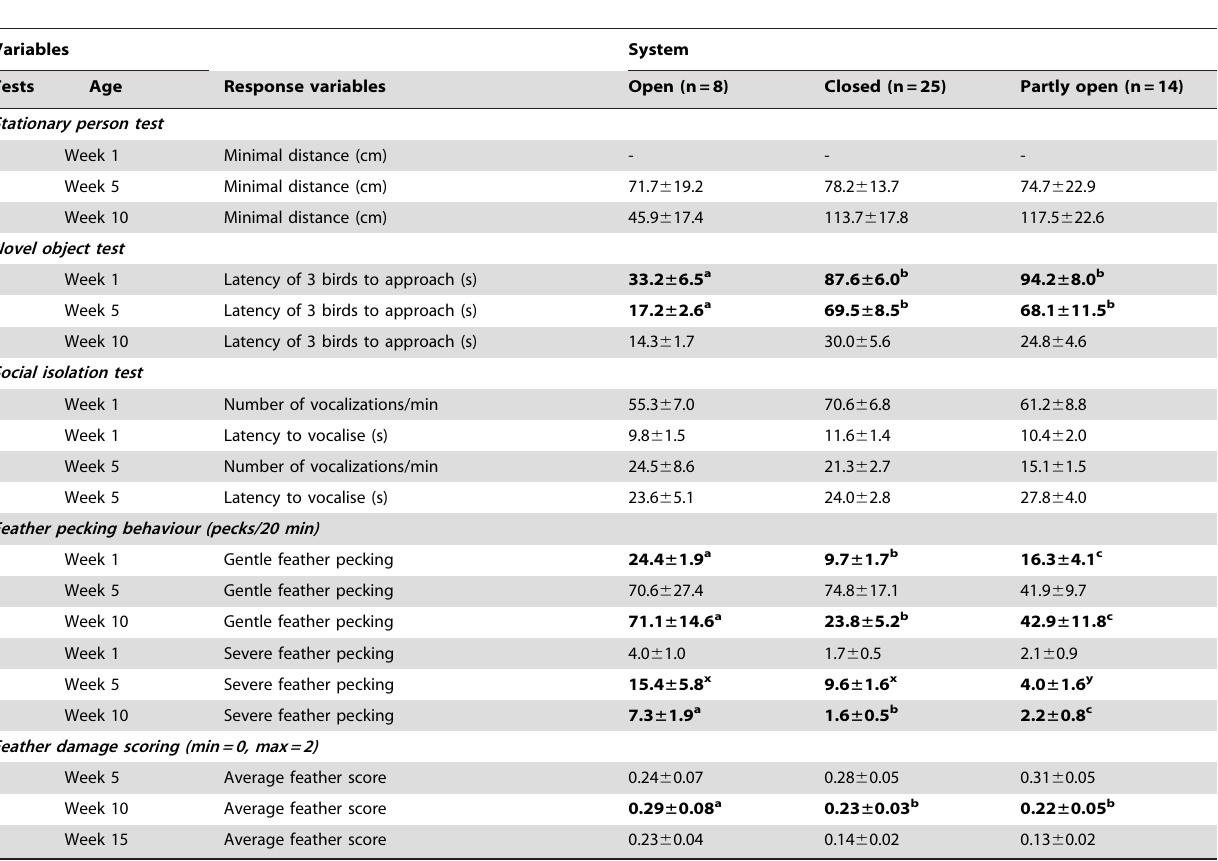
Table 1. Means 6 SEM of response variables of the behavioral tests, feather pecking observations and feather damage scoring of rearing flocks housed in an open, closed or party-open